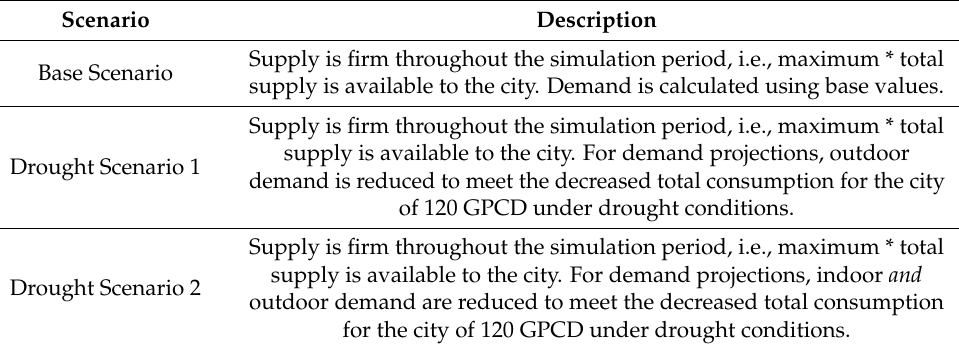
Table 4. Description of